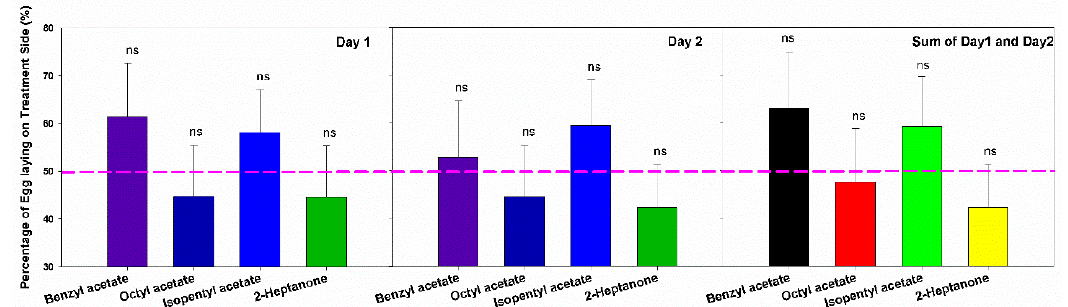
Figure 3. Oviposition site selection between the bee alarm pheromones and Control (benzyl acetate: n = 8, octyl acetate: n = 8; isopentyl acetate: n = 8, and 2-heptanone: n = 8). The pink reference line showed 50%, error bars presented with Mean ± SEM. “ns” means no significant difference.